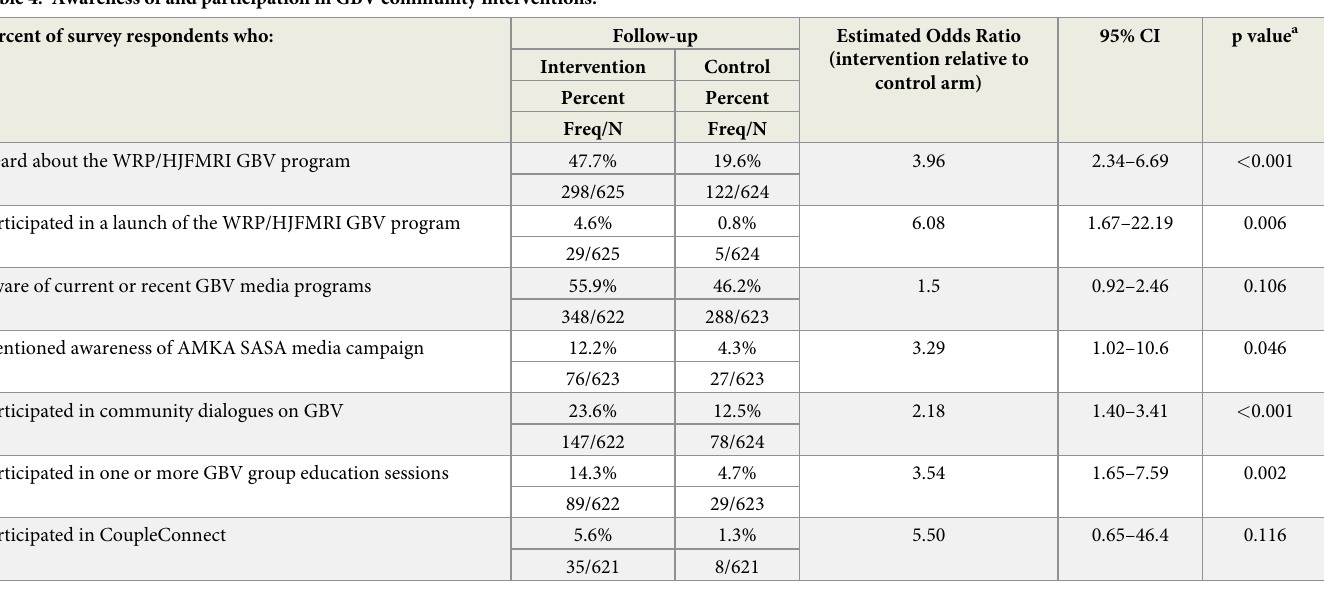
Table 4. Awareness of and participation in GBV community